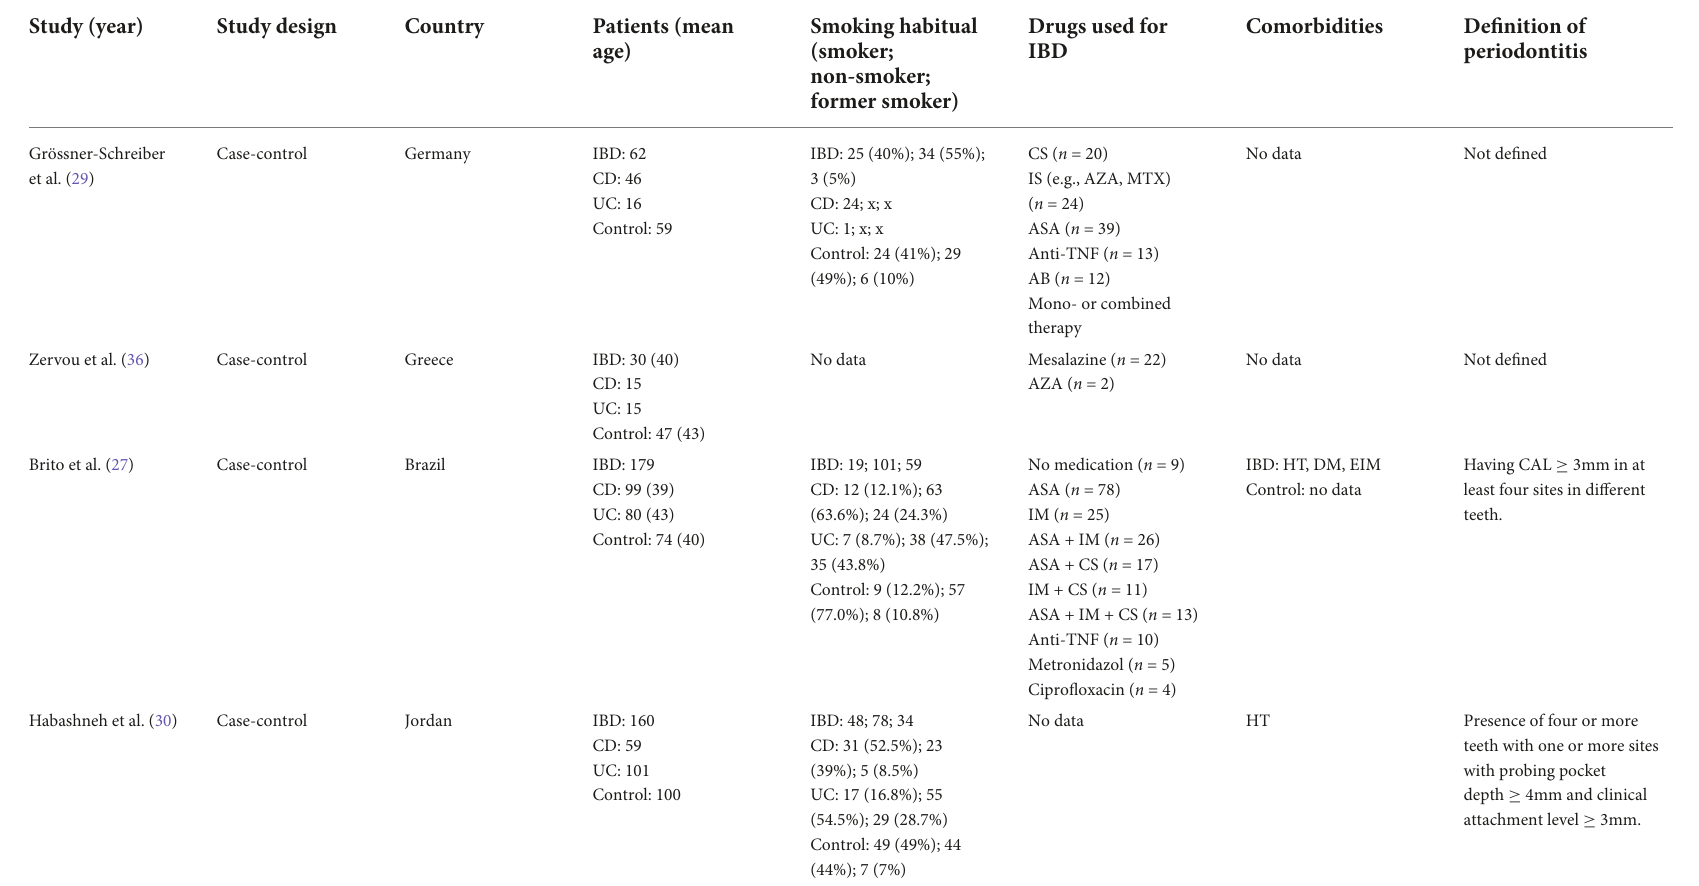
TABLE 1 Basic characteristics of included